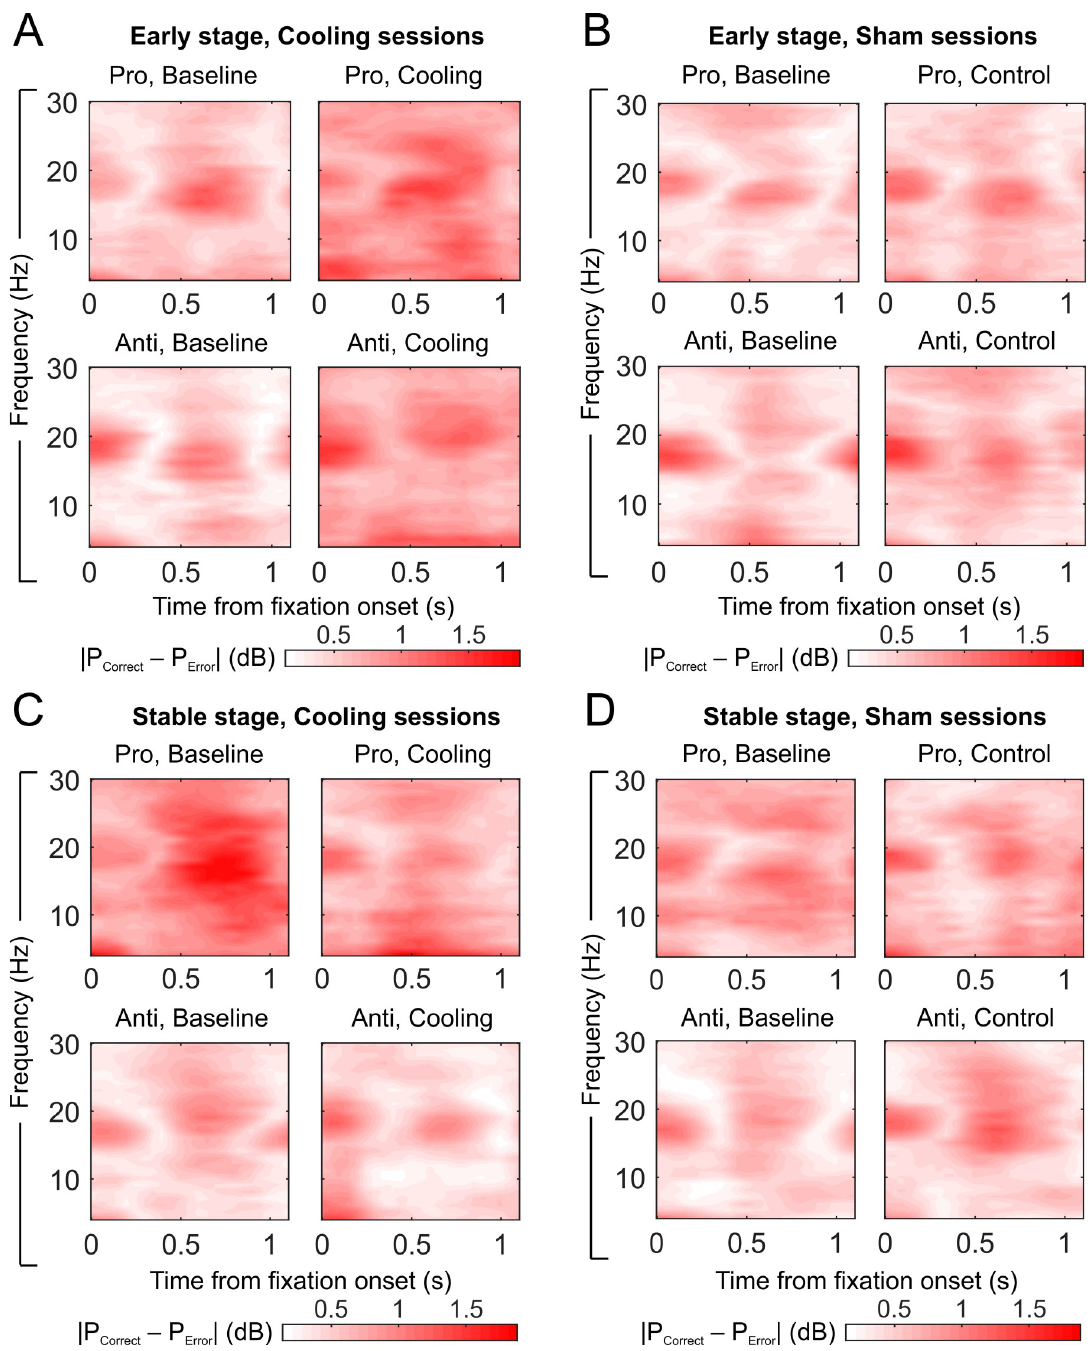
Fig 7. Effects of epoch and dACC deactivation on absolute C-E difference in LFP power. Within each subplot, upper panels show absolute C-E difference under the prosaccade rule, and lower panels show the difference under the antisaccade rule. Left panels show the difference in the baseline epoch, while right panels are based on the cooling/control epoch. The subplots show absolute C-E difference in (A) Early stage in cooling sessions, (B) Early stage in sham sessions, (C) Stable stage in cooling sessions, and D) Stable stage in sham sessions. Data associated with this figure can be found at 10.6084/m9.figshare.8236589. C-E, correct-error; dACC, dorsal anterior cingulate cortex; LFP, local field